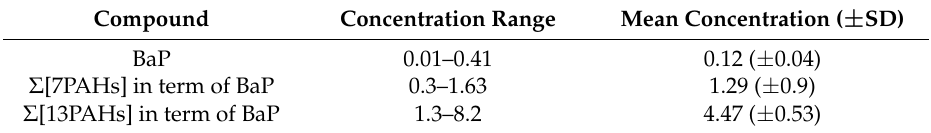
Table 5. Concentration of PAHs ( µ g/g) in terms of BaP in Egyptian milk and dairy-based products ( n = 24).